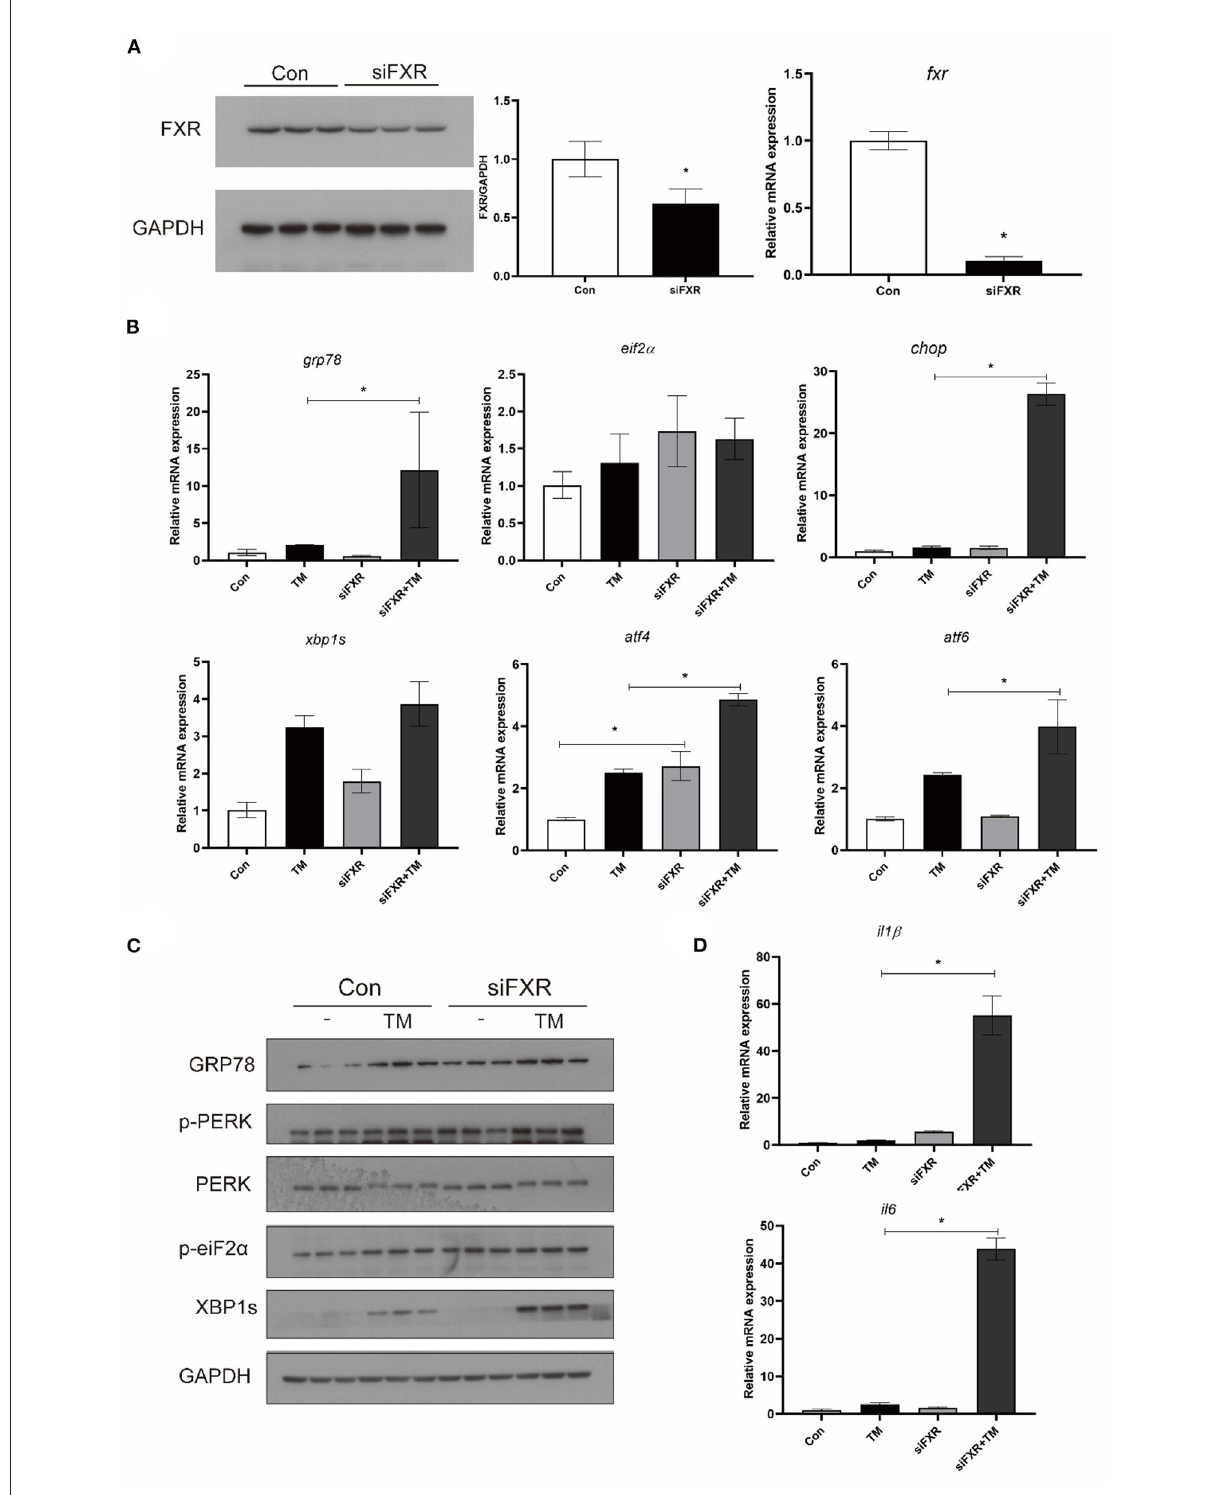
FIGURE6 Effects of (A) FXR knockdown on TM-induced ER stress and inflammation in croaker macrophages. (B) Gene expression and (C) protein level of ER-stress markers in macrophages with stable interference for FXR after TM treatment. (D) Expression of IL1 β and IL6 in macrophages with stable interference for FXR after TM treatment. *Different between two groups; P < 0.05 (means ± SEMs; n = 3; Student’s t